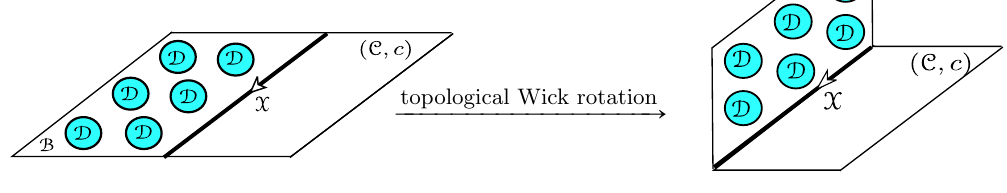
Figure 12 . These two pictures depict a physical description of pure edge phase transition via a topological Wick